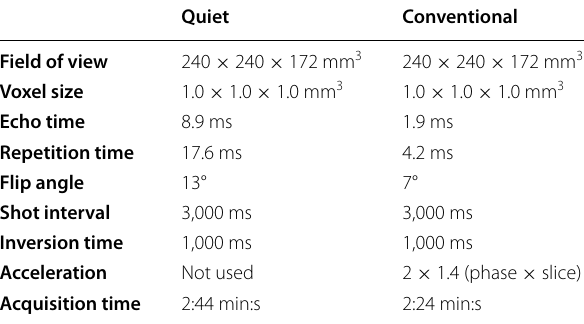
Table 1 Imaging parameters of the quiet and conventional sequence Quiet